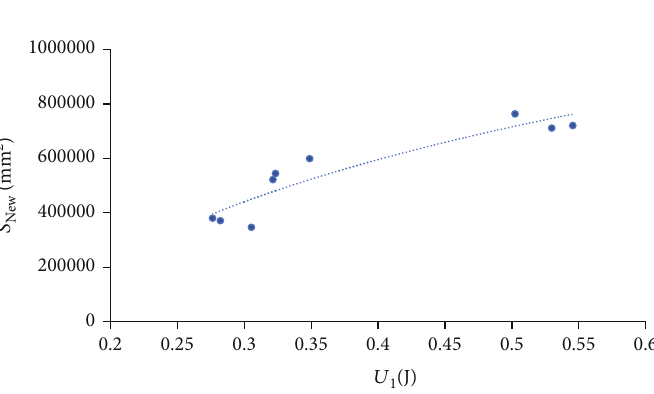
U ff erent lithology combination New and 1 of the di